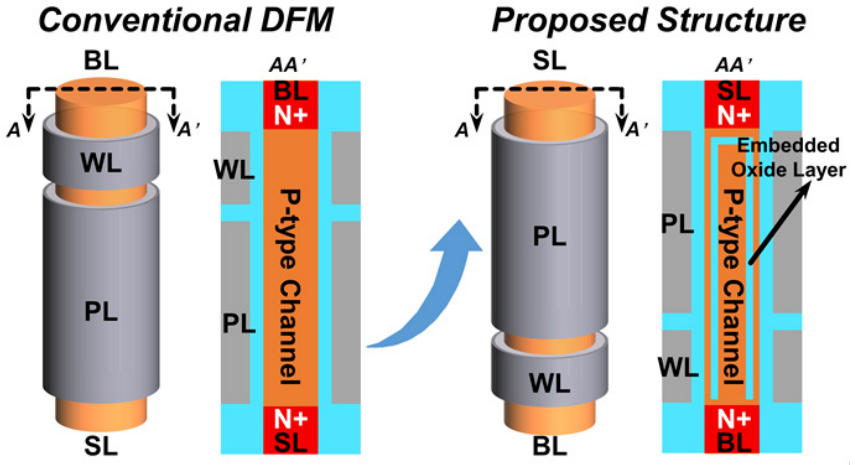
Figure 1. The structure of the conventional DFM and the novel proposed structure of the capacitorless 1T DRAM with embedded oxide layer.